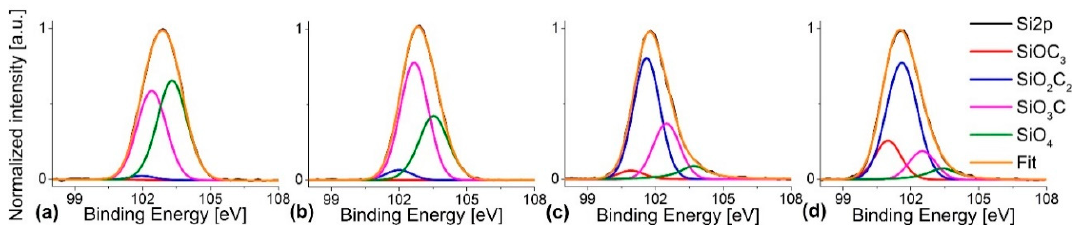
Figure 6. The high-resolution spectra of Si2p peak for 0.5 mL silicone-coated paper plasma pre/post- treated in air for 0.5/0.5 s ( a ), 0.5/5 s ( b ), and 5/5 s ( c ) and pretreated 0.5 s in air and post-treated 0.5 s in nitrogen ( d